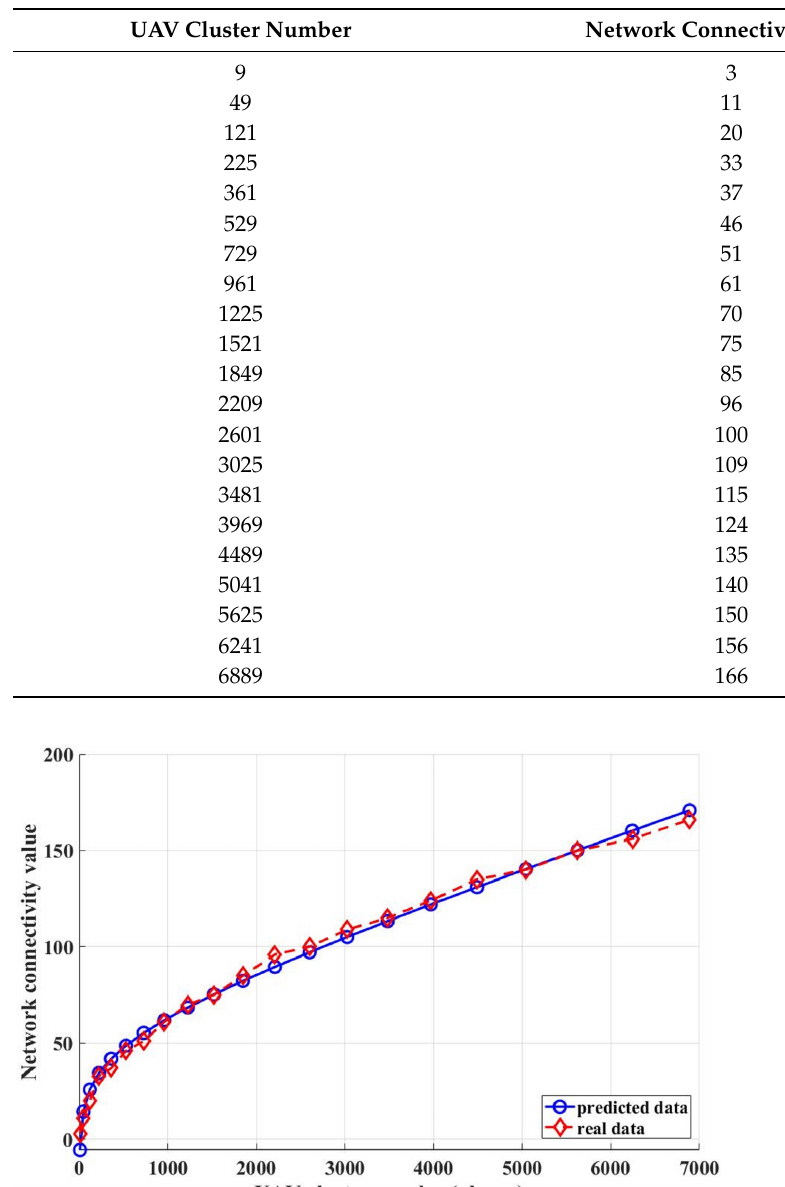
Table 2. Network connectivity values of different-scale UAV formations.